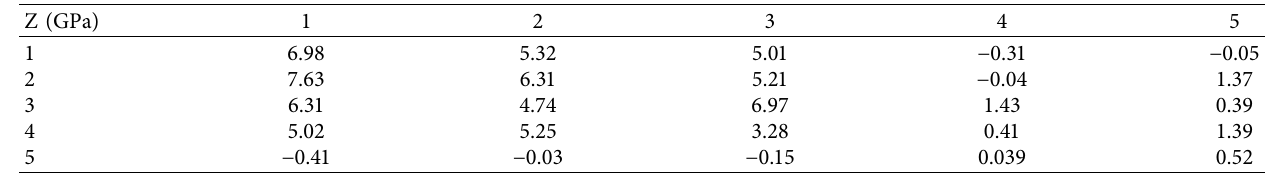
Table 2: Nanoparticle unit cell elastic stiffness